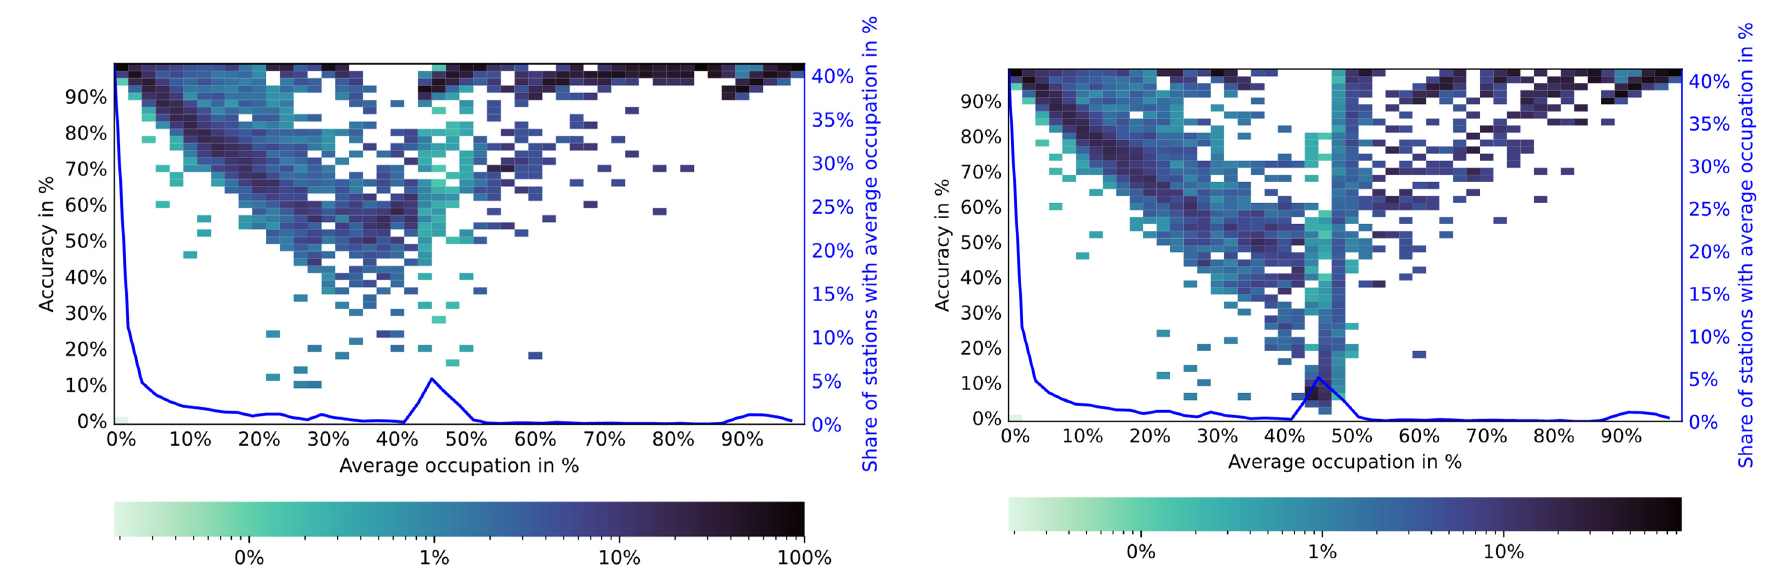
Figure 3. Accuracy of GB with all available inputs in 2021 ( left ) and of AW again for 2021 ( right ). The colour indicates which share of stations with the given average occupation was predicted with which accuracy. The heat map is constructed of rectangles with 2% edge length in both dimensions. Example of how to read: A dark green square corresponding to 80% with an average occupation of 50% and accuracy of 90% indicates that, for all stations with an average occupation of 50% to 52%, the prediction model achieved accuracy between 90% and 92% in 80% for all CS falling into the category. The blue line indicates what share of stations fell into each 2% block of average occupation.